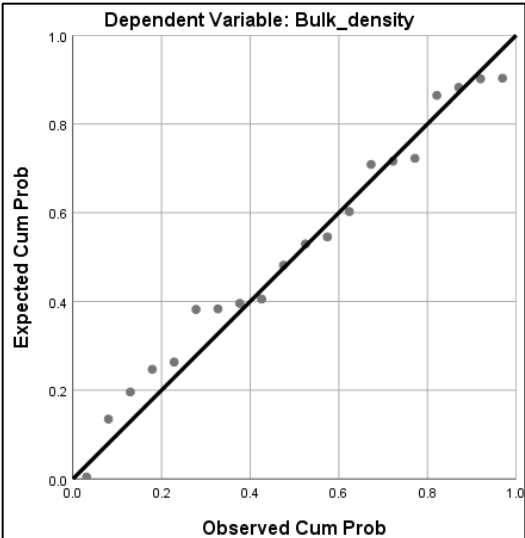
Figure 10. Normal P-P Plot of regression of the standardized residual of bulk density (dependent variable).